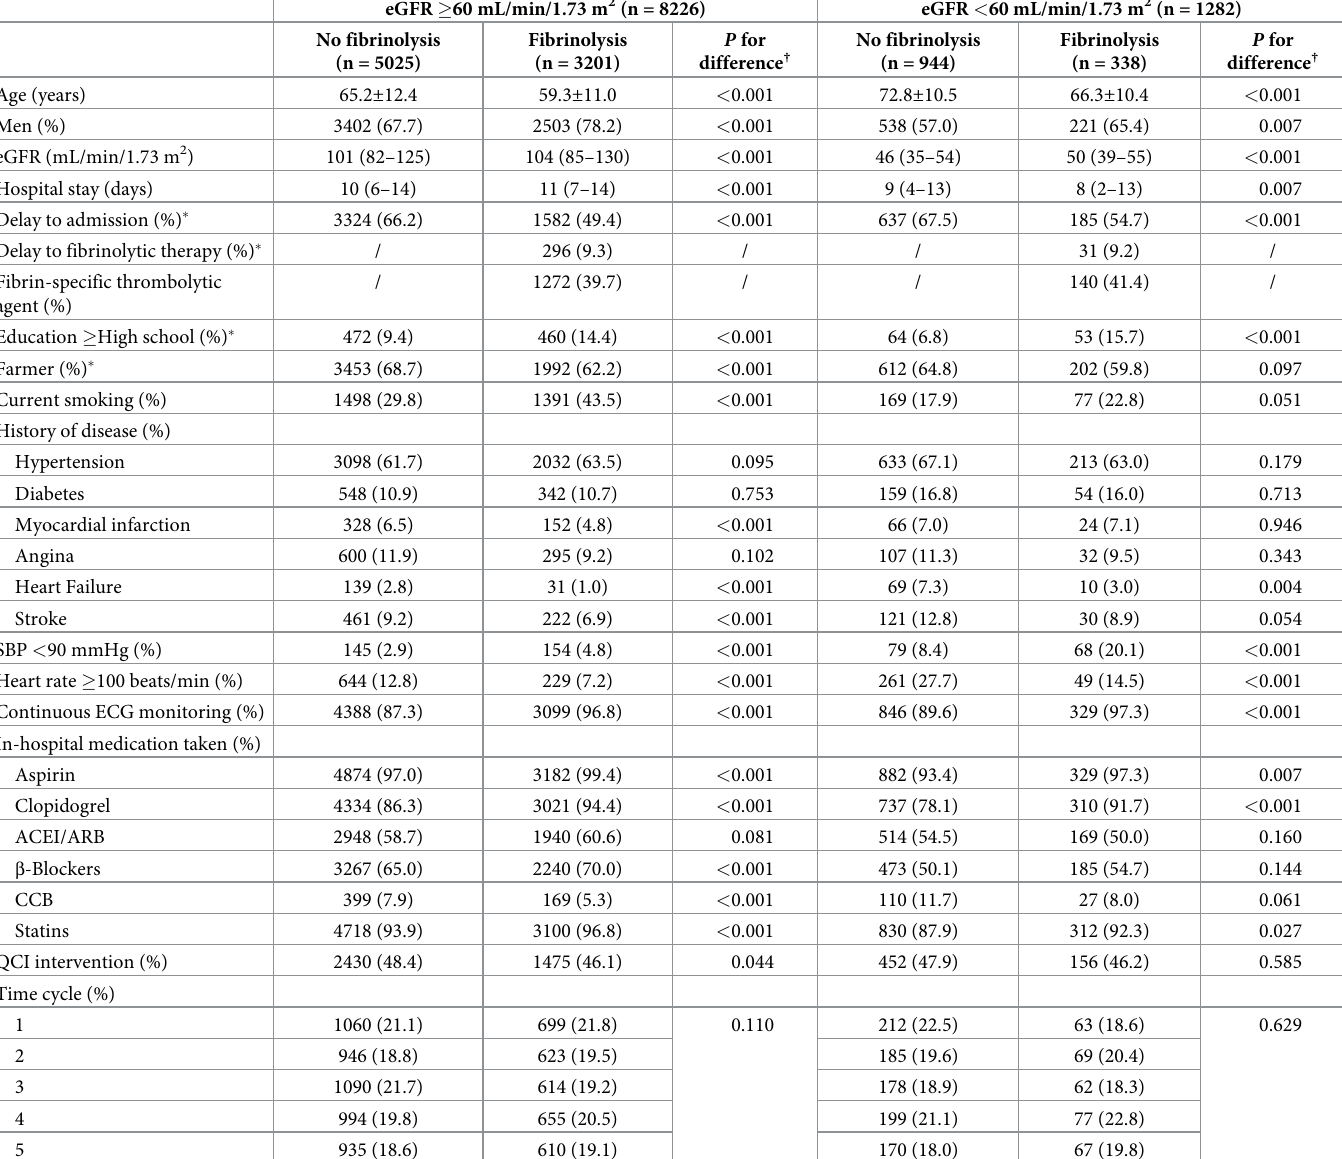
Table 1. Baseline characteristics between participants who did and did not receive fibrinolytic therapy, by the presence of reduced kidney function (eGFR < 60 mL/ min/1.73 m 2